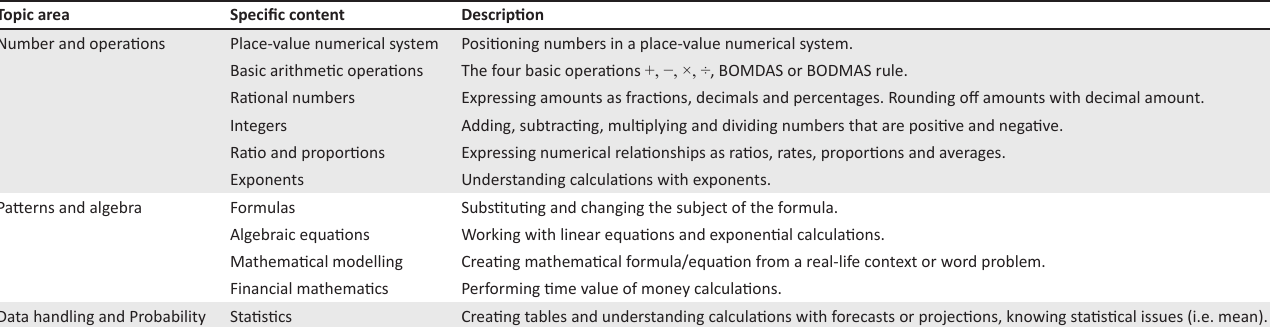
TABLE 1: Summary of mathematical content needed for